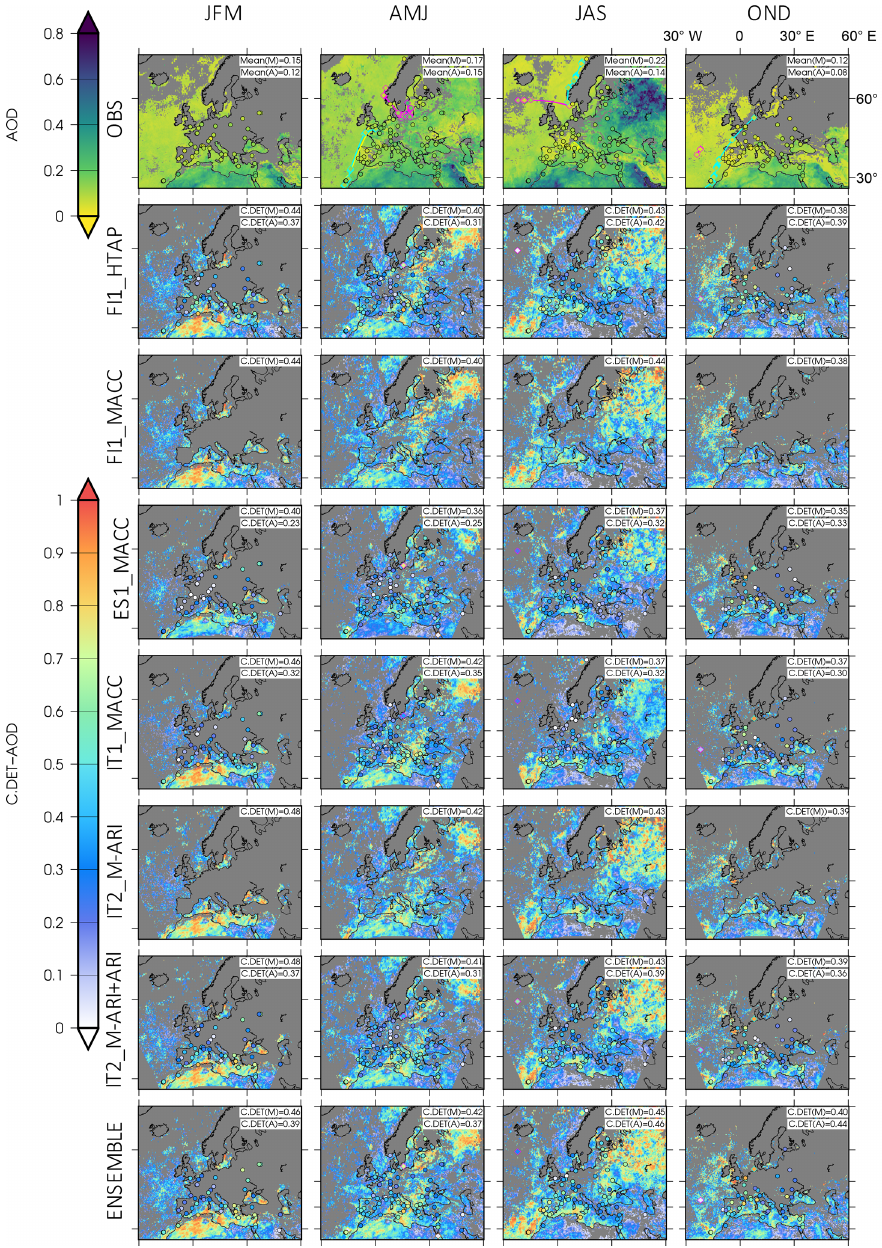
Figure 4. The same as Fig. 2 for the determination